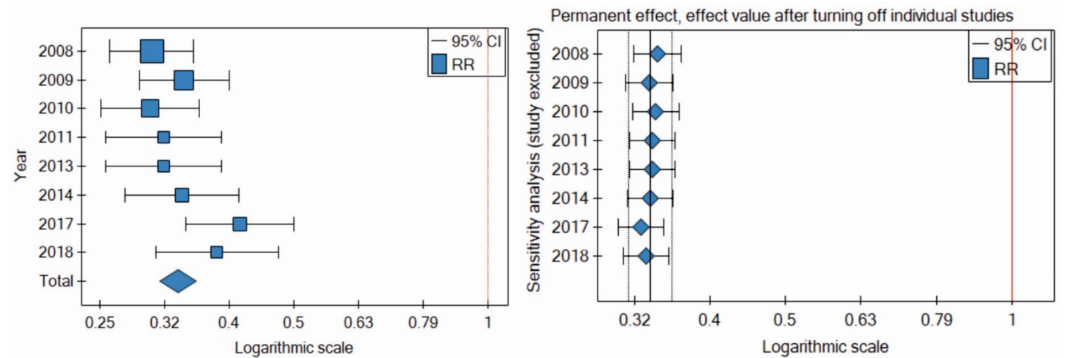
Figure 1. The relative risk of an accident at work among employees up to 18 years old employed in Poland (own elaboration).